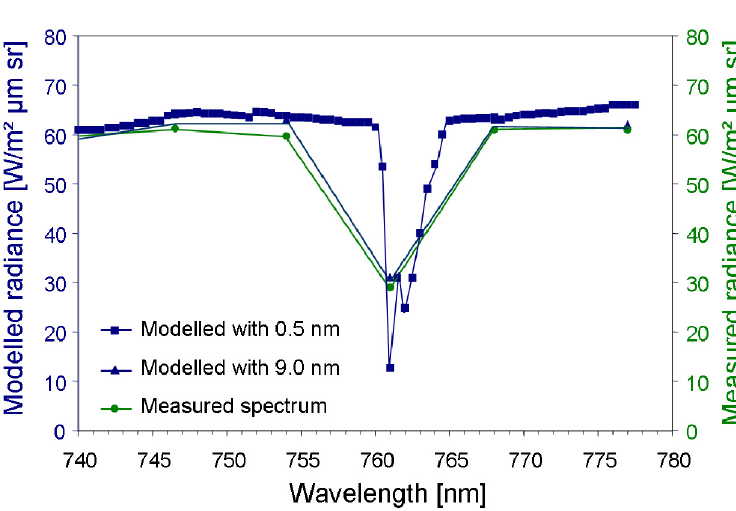
Figure 7. Comparison of simulated MODTRAN radiances and AVIS-2 measurements of